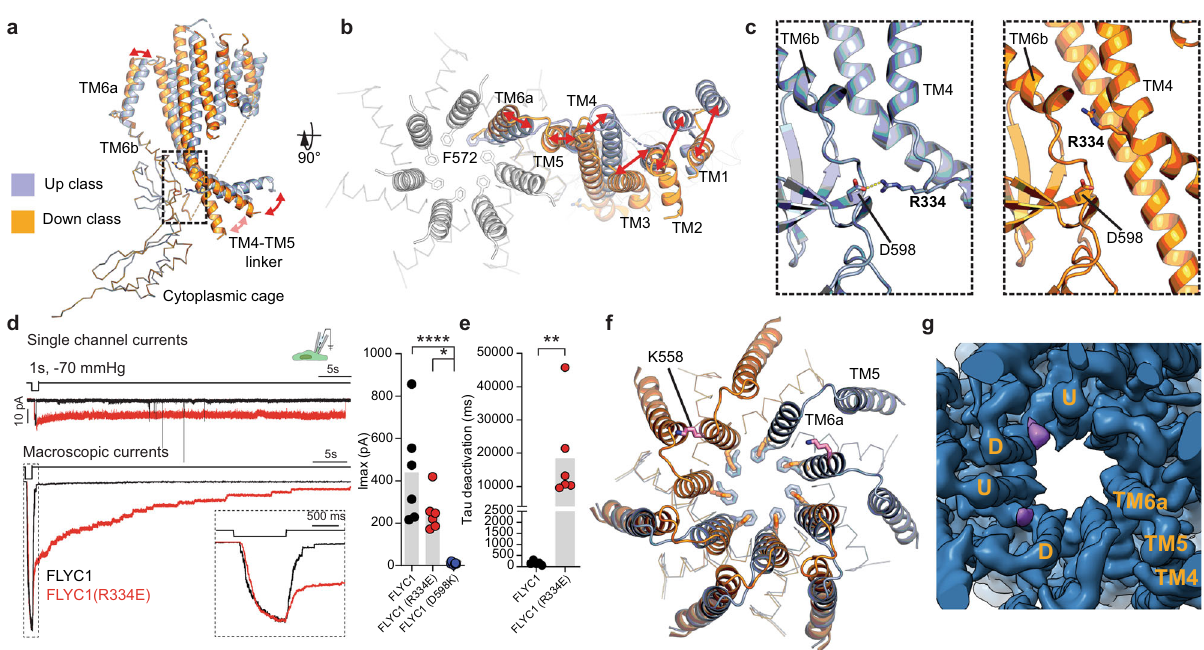
Fig. 4 Conformational dynamics of FLYC1 protomer. Side ( a ) and top ( b ) views of superposed up and down classes. Movement of helices denoted by red arrows. F572 shown as sticks. In top view, TM6a of all subunits is shown. c Expanded view of window in a , showing the presence of a salt bridge between R334 and D598 in the up (left) but not in the down class (right). d Left, representative stretch-activated currents from WT (black) or R334E mutant (red) FLYC1 in the cell-attached patch clamp mode in response to 1 s pulse of − 70 mmHg pressure at − 80 mV. For comparison, currents are normalized and overlaid. Top, single channel current; bottom, macroscopic current. Inset depicts enlarged section of the macroscopic trace to highlight that channel activation and inactivation are largely similar between WT and R334E. Right, quanti fi cation of maximal current response from cells transfected with FLYC1 plasmid ( N = 6), R334E mutant ( N = 6), or D598K mutant ( N = 9). **** p = 0.000036; * p = 0.0104, one-way ANOVA. e Mean deactivation kinetics of WT ( N = 6) or mutant ( N = 6) FLYC1 channel; ** p = 0.0043, Mann – Whitney test, two-tailed. In panel d and e , individual cells are illustrated as scatter and mean is represented by grey bars. N = number of cells tested and pooled from different experimental days. f Superposition of hypothetical C7 ‘ all-up ’ and ‘ all-down ’ classes. Two top left and two top right subunits show only down and up protomers, respectively. F572 ring is shown for all subunits in both conformations. The position and orientation of K558 are shown in pink for only two subunits. g First frame of fi rst component of 3D variability analysis. Subunits are labeled up (U) or down (D) depending on their conformation. Lipid-like density is colored two distinct classes of the FLYC1 protomer we initially saw in our C1 reconstruction (Supplementary Fig. 1). A striking difference between the classes is the conformation of the cytosolic TM4- TM5 linker, which can be in an up or down conformation (Fig. 1a, b). In the up conformation, the TM4-TM5 linker is parallel to the membrane plane, while in the down conformation, the linker swivels towards the cytosol (Fig. 4a). Importantly, the conformational fl exibility of the cytosolic domains is associated with movement of the TMD, suggesting that it is likely associated with channel gating. TM1-TM5 are displaced in a clockwise manner in the down state compared to the up state when viewed from the extracellular side (Fig. 4b). In the down state, a short six- residue coil (P96-S101) from the N-terminus interacts near the